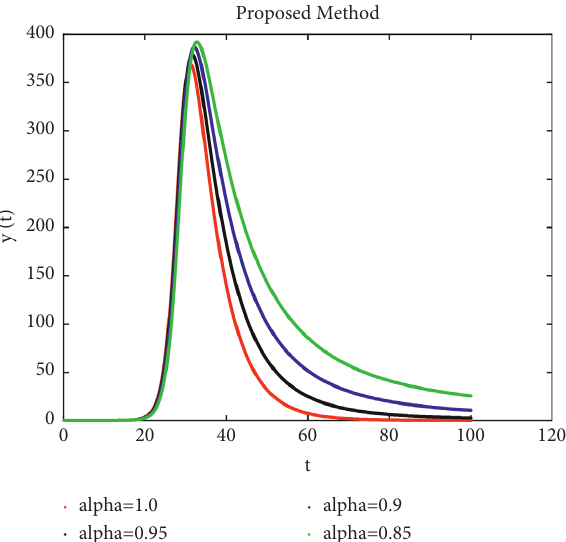
Figure 6: Dynamical behavior infected cells at τ � 1 and various fractional order under power law kernel.